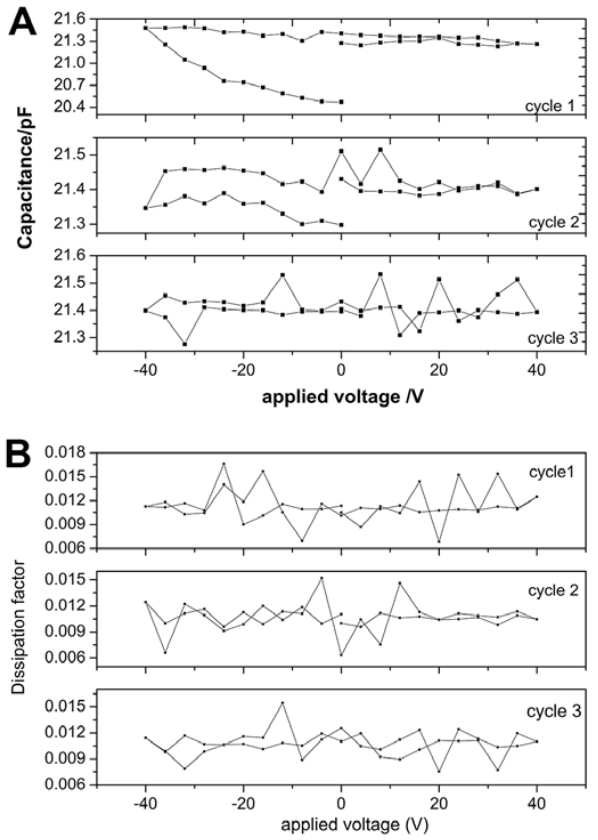
Figure 7. Capacitance ( A ) and loss factor ( B ) of the PFMA dielectric layer with the thickness of 1.4 μm at different applied voltages.